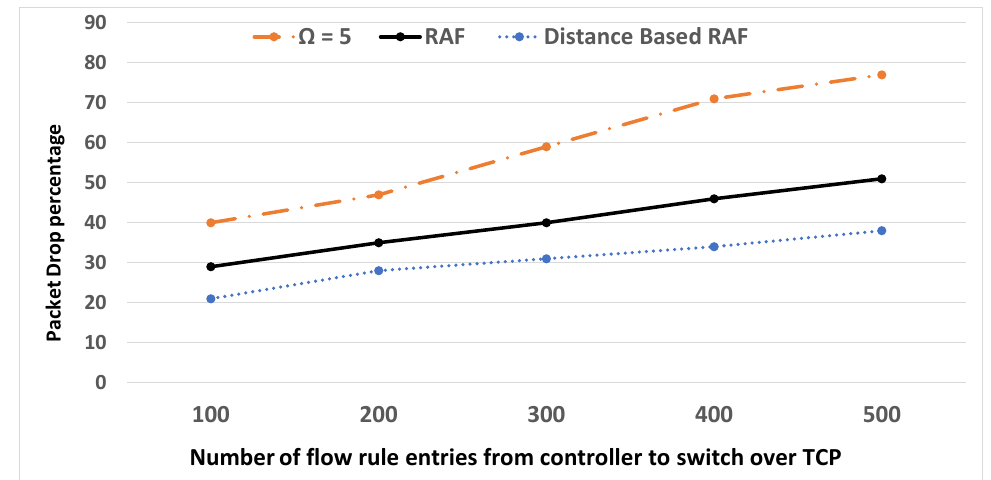
Figure 7. Flow entry drop percentage in case of switch memory overflow. Observations regarding the average delay of flow rules installation in Figure 8 con- clude that as the number of flow rules entries increases, the time of their installation also increases proportionally. Handling multiple applications of the controller results in the pro- longed delay for device configurations. RAF and DRAF reduce the delay and synchronize the immediate configurations.